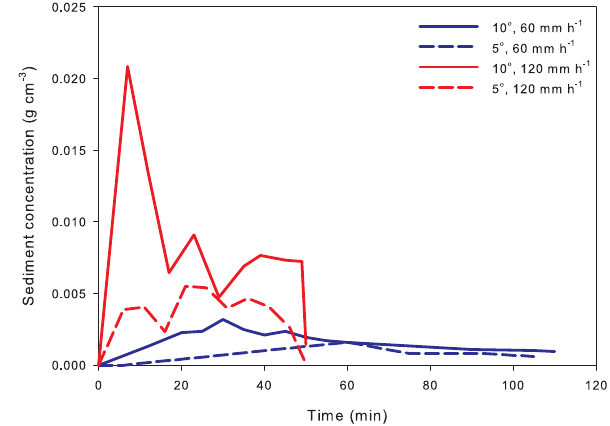
Figure 3. Plot showing sedigraphs for each of the slurry-treated slope